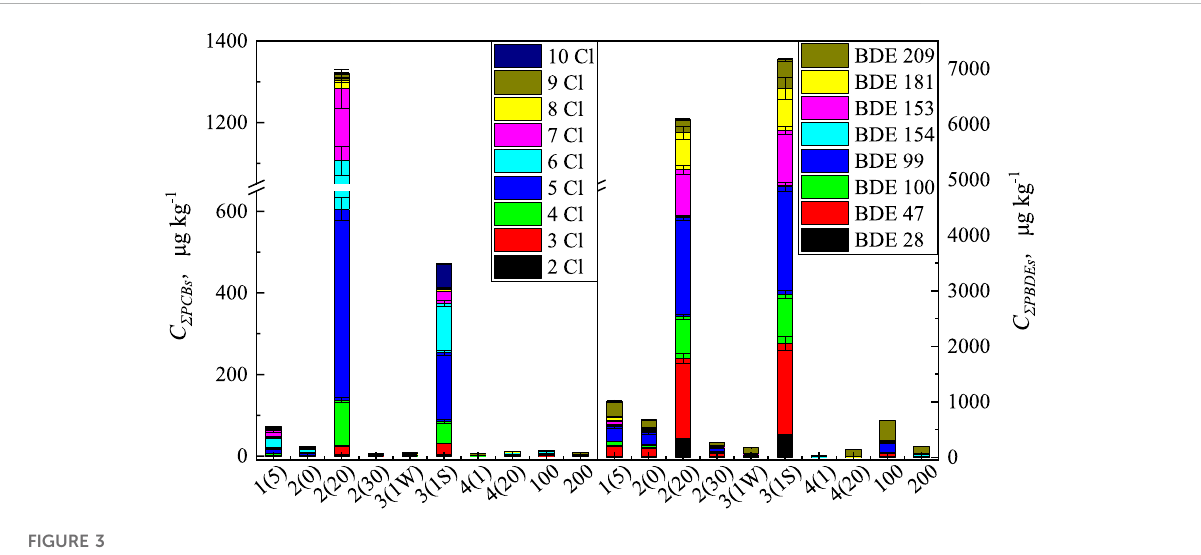
FIGURE 3 Distribution of Σ 20 PCBs and Σ 8 PBDEs in the dismantling ruins and surrounding soils. 1(5): 5 m away from No. 1 ruins; 2(0): No. 2 ruins; 2(20): 20 m away from No.2 ruins; 2(30):30 m away from No.2 ruins; 3(1S):1 m away to the south of No.3 ruins; 3(1W): 1 m away to the west of No.3 ruins; 4(1): 1 m away from No.4 ruins; 4(20): 20 m away from No.4 ruins; 100: 100 m away from No.1, No.2 and No.3 ruins; 200: 200 m away from No.1, No.2 and No.3